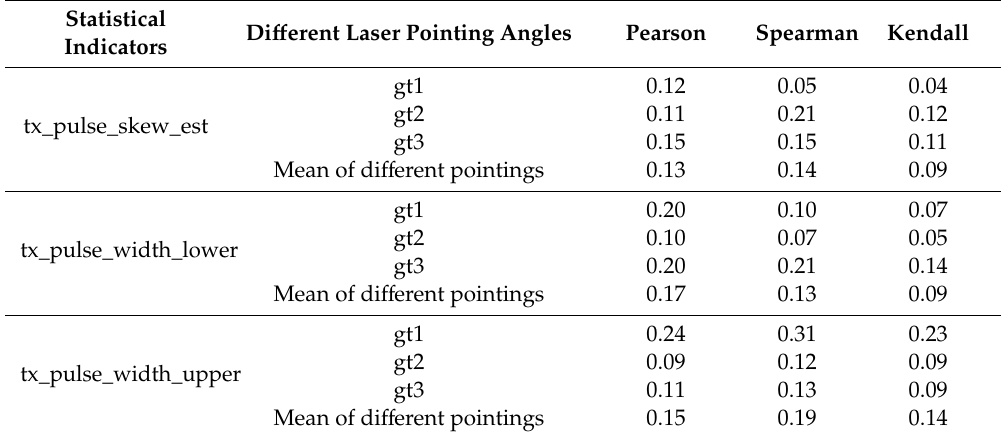
Table 8. The correlation coe ffi cient statistics between tx_pulse_skew_est, tx_pulse_width_lower, tx_pulse_width_upper parameters and the elevation errors of ATLAS